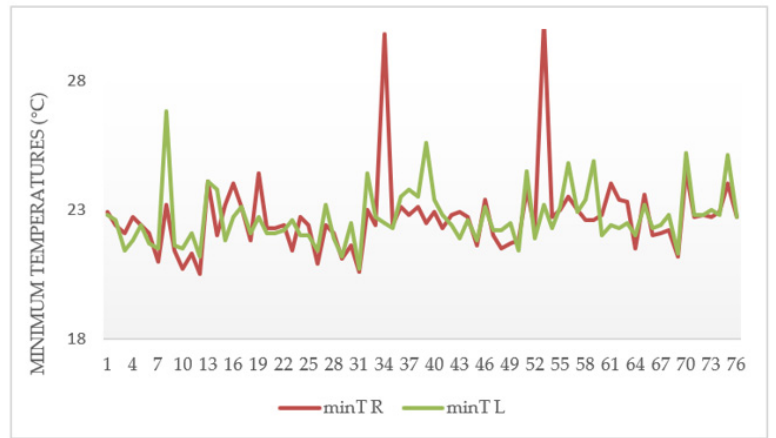
Figure 9. Graphs of minimum temperature differences between minT R (right wrist minimum temperature) and minT L (left wrist minimum temperature) points of subjects from the sanding area. The minT R point represents the minimum temperature of the right wrist (palm side), and the minT L point corresponds to the minimum temperature of the left wrist (palm side). Ten cases of thermal asymmetries were observed in the graph of Figure 10, which represents subjects probably suffering from a